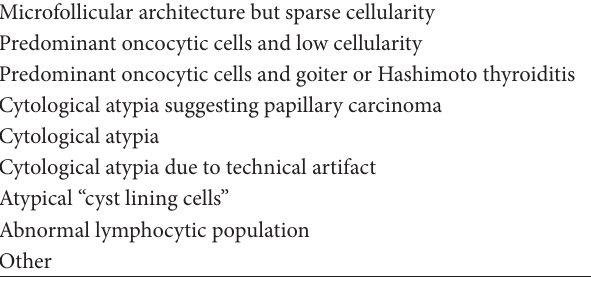
Table 2: Cytological criteria for FLUS diagnosis according to the BSRTC.